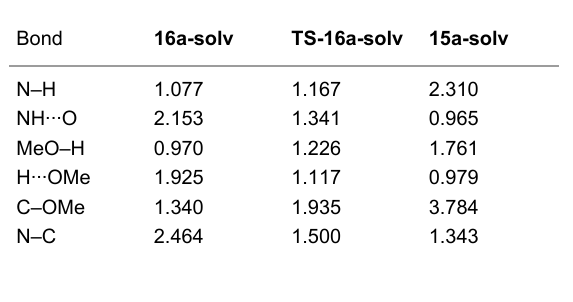
Table 3: Selected bond distances (Å) for the structures optimized along the transformation 16a-solv → 15a-solv